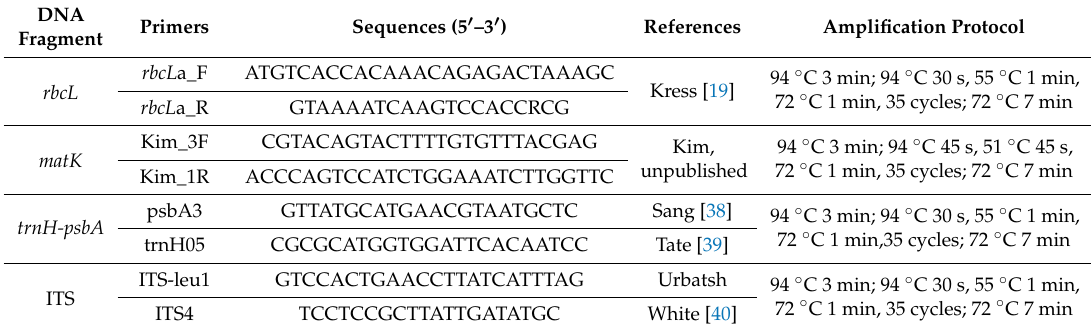
Table 2. The primers used to amplify DNA barcodes and the amplification